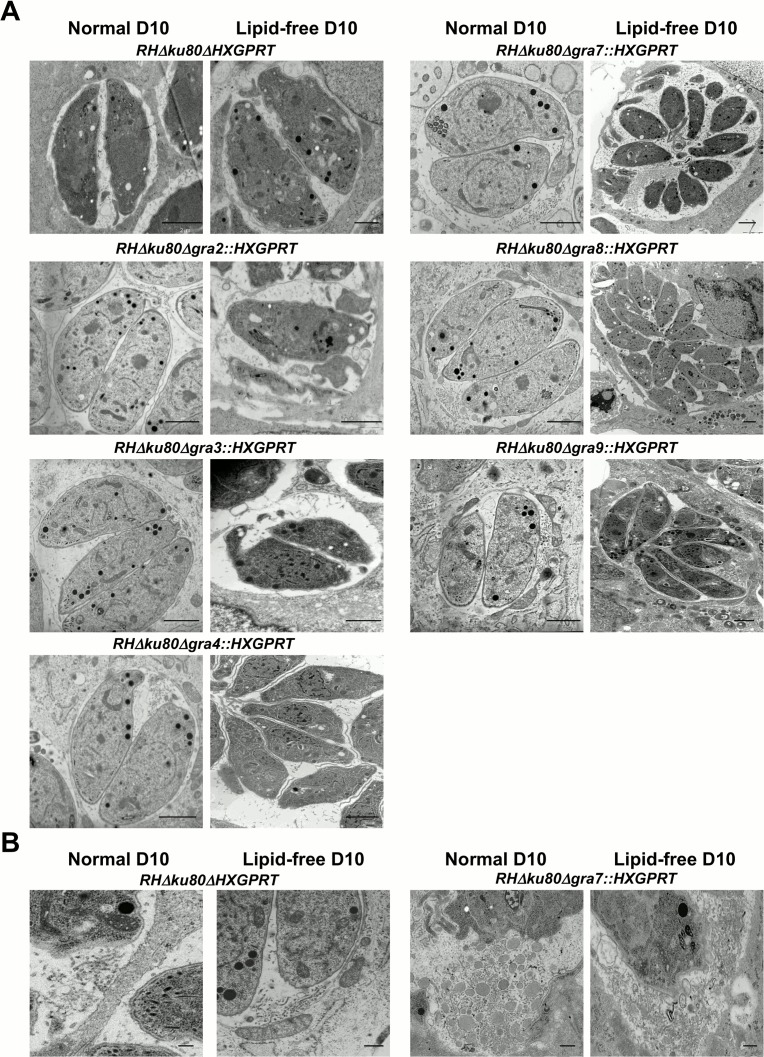
Visualization of the Δgra2-9 knockout parasites and PV morphology by transmission electron microscopy.A) HFFs and parasites were cultured in D10 medium (“Normal D10”) or pre-equilibrated in lipid-free D10 medium (“Lipid-free D10”). Host cells were infected overnight with Δgra2-9 knockout or parental strains, fixed, and then processed for transmission electron microscopy. Scale: 2 μm. B) Magnification of the posterior end of an intracellular Δgra7 knockout parasite in “Normal D10” and in “Lipid-free D10” showing the hyper-formation of the IVN. Scales: 2 μm.